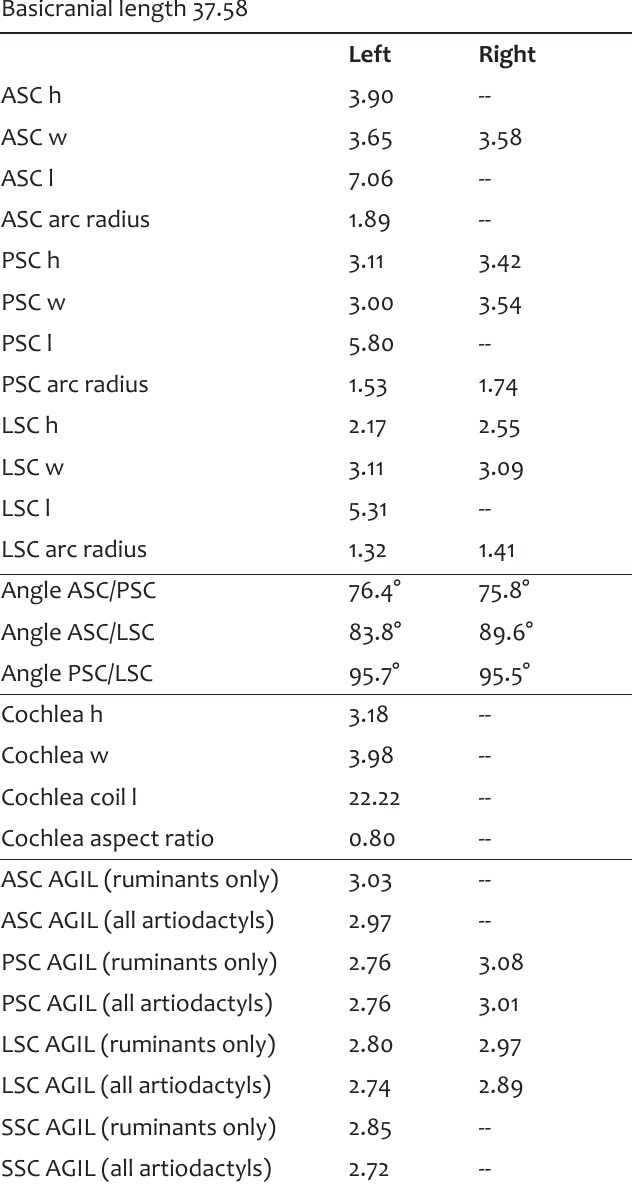
Table 1. Measurements of SDSNH 47878, and body masses and agility scores inferred based on those measurements. Length measurements are in mm and mass measurements are in kg. Agility scores are unitless. Abbreviations: AGIL, agility score; ASC, anterior semicircular canal; h, height; l, length; LSC, lateral semicircular canal; PSC, posterior semi- circular canal, w,